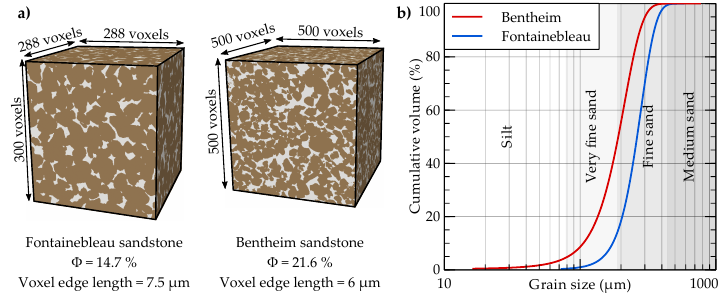
Figure 3. ( a ) Size and resolution of the binary micro-CT scans for the digital sandstone samples [59,70]. The voxel edge length of the original Bentheim microstructure is reduced to 6 µ m to achieve a grain resolution equivalent to the Fontainebleau microstructure. ( b ) Both sandstones have similar grain size distributions, while the Bentheim sandstone has a slightly wider distribution in particle